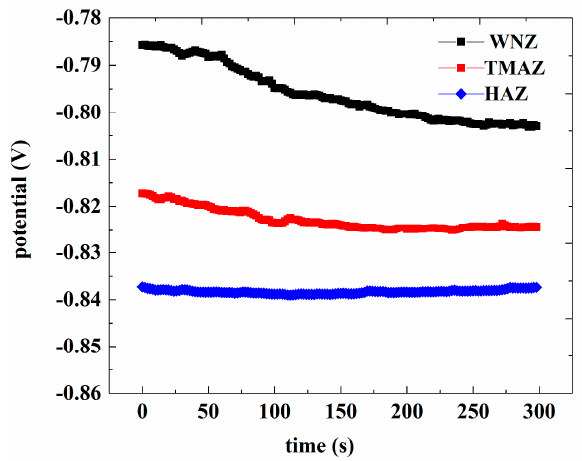
Figure 11. Open potentials of the welded joint in 3.5 wt.% NaCl solution in different positions.